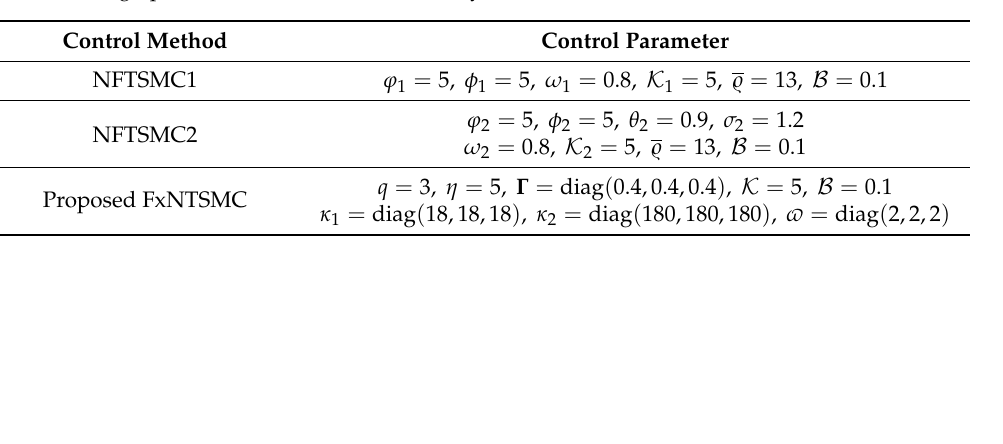
Table 3. Design parameters of the three control